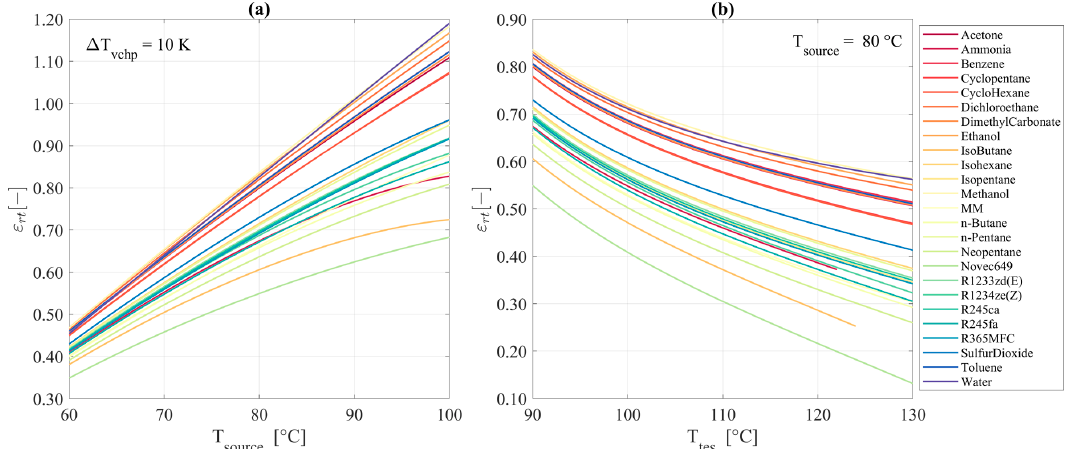
Figure 4. TI-PTES roundtrip efficiency ε rt for several operating fluids. The results are related to the configuration in Figure 6 investigated in [22]. ( a ) ε rt for different heat source temperature ( T source ) levels and fixed VCHP temperature lift Δ T vchp = 10 K . ( b ) ε rt for different TES temperature ( T tes ) levels and fixed heat source temperature T source = 80 °C.